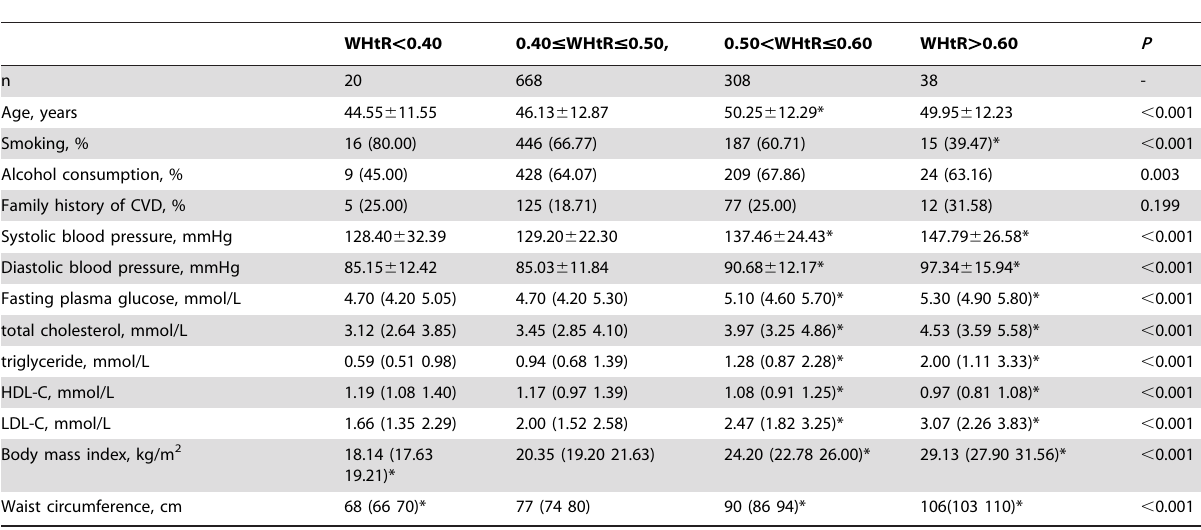
Table 1. Baseline Characteristics of Participants Stratified According to Values of WHtR.